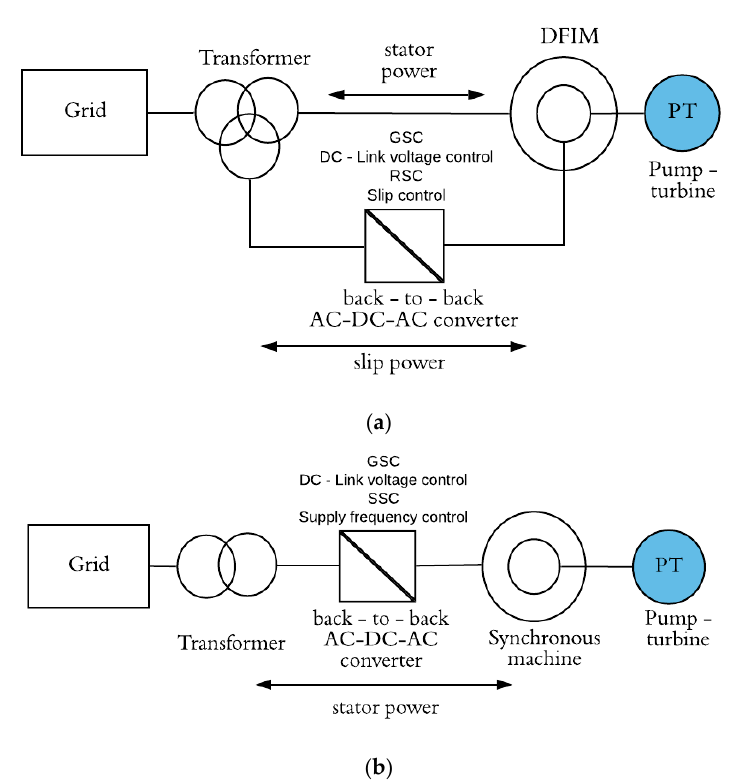
Figure 1. Adjustable speed pumped storage hydro: ( a ) Employing doubly fed induction machine (DFIM) with a rotor side converter; and ( b ) employing synchronous machine. GSC—Grid side converter, SSC—Stator side converter, RSC—rotor side converter.